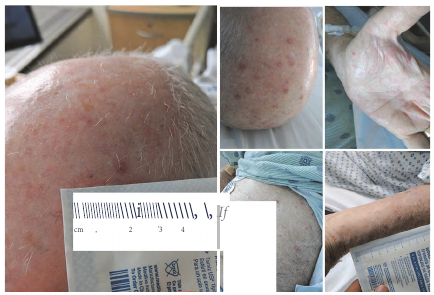
Figure 1: Clinical presentation: firm, indurated, erythematous papules, and nodules, with central pustules and vesicles on the head and scalp. Indurated papules on the palms of the hand. Erythematous pustules on the